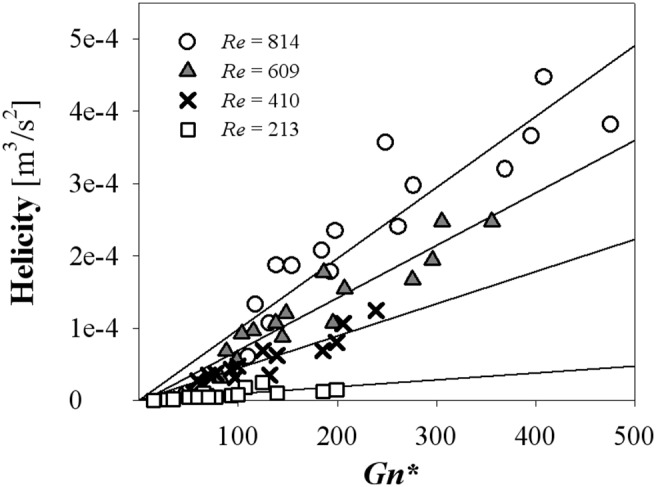
Helicity variations at the outlet surface with respect to Gn*.